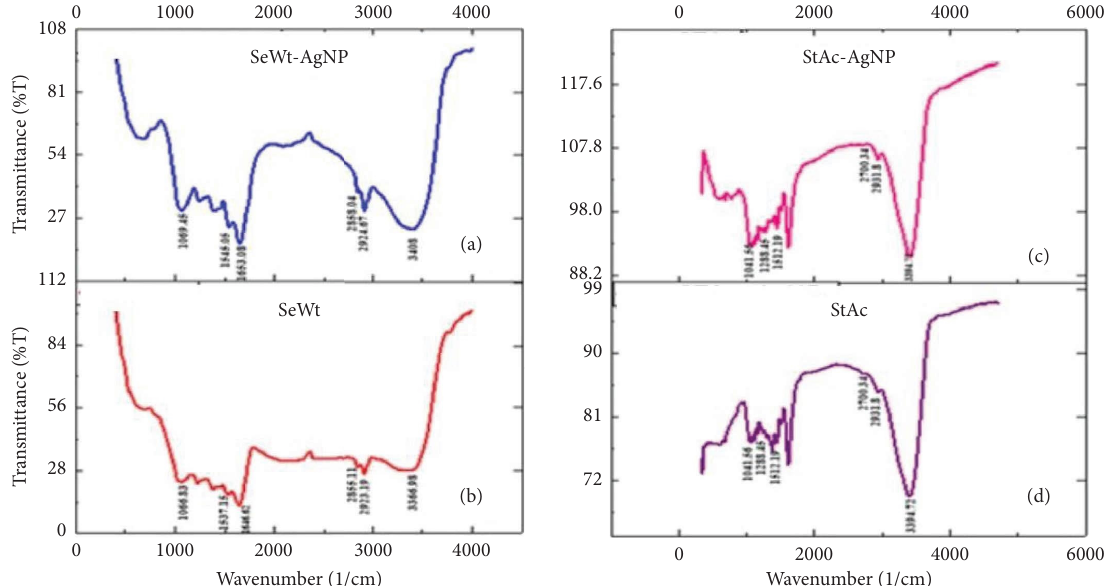
Figure 7: FTIR peaks showing (a) functional groups of SeWt-AgNPs, (b) functional groups of SeWt, (c) functional groups of StAc-AgNPs, and (d) functional groups of